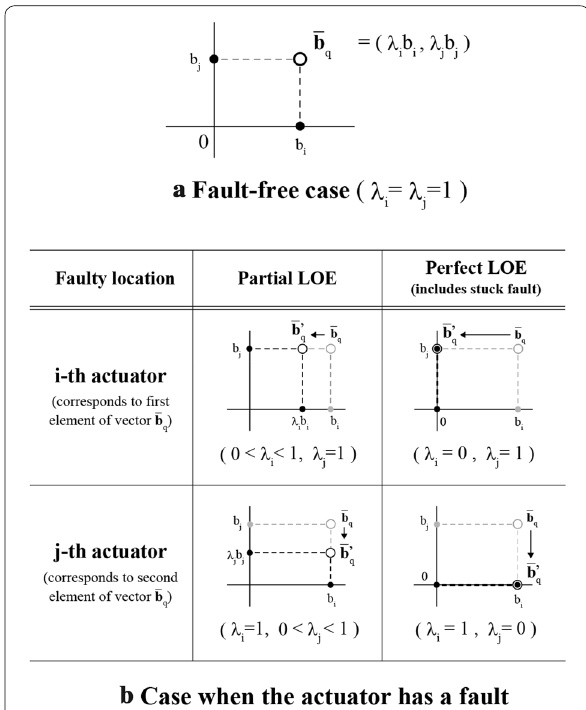
Fig. 6 Changes of vector ¯ b by corresponding fault patterns